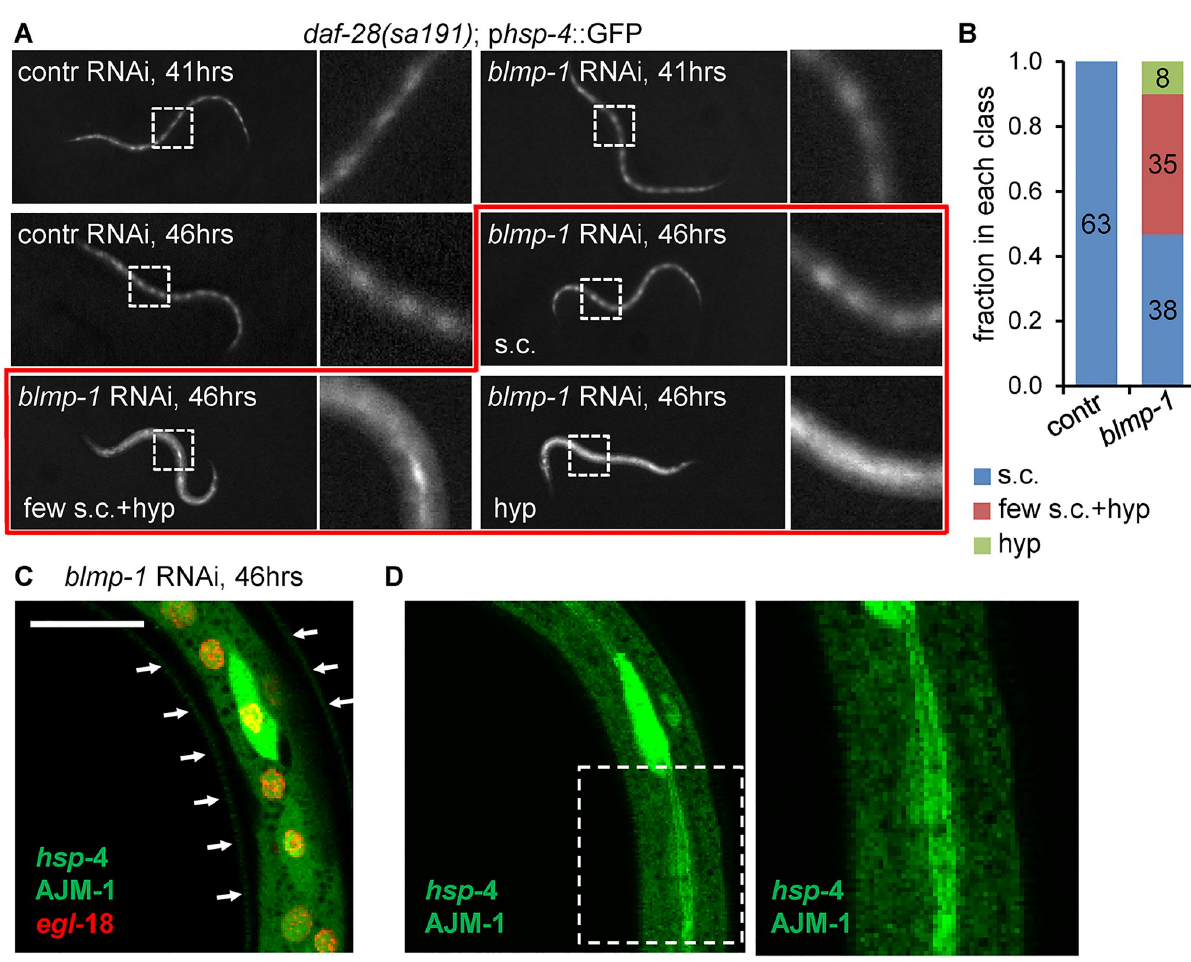
Fig 3. BLMP-1, the C . elegans orthologue of mammalian transcriptional regulator BLIMP1, represses hsp-4 induction in the hypodermal lineage during differentiation of the alae-secreting cells. (A) Fluorescence micrographs of daf-28(sa191) animals at the early (41 hours postgastrula) and late (46 hours postgastrula) L2d stage. Down-regulation of blmp-1 expression by feeding RNAi results in strong induction of the hsp-4 reporter in the lateral hypodermis (indicated in the figure as: hyp) in a fraction of late L2d stage animals, as well as occasional hyperinduction in a few seam cells in addition to the induction in the hypodermis (few s.c. + hyp). An animal with normal induction in seam cells is indicated as (s.c.). Imaging as in Fig 1A. (B) Quantitation of the different hsp-4 induction classes in animals shown in panel A. Animals that initiated the L2d stage were picked from indicated RNAi plates based on their morphology, using transmitted light only, and then scored for either normal hsp-4 induction (s.c.), induction in the hypodermis (hyp), or induction in the hypodermis with hyperinduction in some seam cells (few s.c. + hyp). Numbers inside the bars indicate number of animals scored in each class, pooled from 3 independent RNAi experiments. (C, D) Confocal images of a representative animal with (few s.c. + hyp) pattern of hsp-4 reporter induction following blmp-1 RNAi. Images show p hsp-4 ::GFP (green), AJM-1::GFP (green), and p egl-18 ::H1-wCherry (red). (C) A single-plane image, taken at a deeper focal plane through the lateral hypodermis, at the level of nuclei. Red signal indicates nuclei of both hypodermal and seam cells. hsp-4 induction can be seen in the hypodermis; one hyperinduced seam cell is also visible. The arrows outline the animal’s body. (D) Left panel shows a z-projection of the lateral hypodermis in the green channel only, same area as in C. Right panel is a close view of the boxed area, showing a single plane at the level of apical junctions. The AJM-1::GFP outlines the boundary between the seam cell and hypodermis. Scale bar: 10 μ m. AJM, Apical Junction Molecule; BLMP-1/BLIMP1, B-Lymphocyte-Induced Maturation Protein 1; contr, control; daf-28(sa191) , an allele causing ectopic L2d entry; p egl-18 , egl-18 promoter, active in the posterior seam cells after asymmetric divisions; GFP, green fluorescent protein; HSP-4, Heat-Shock Protein 4; L2, second larval stage; L2d, predauer L2; RNAi, RNA interference.